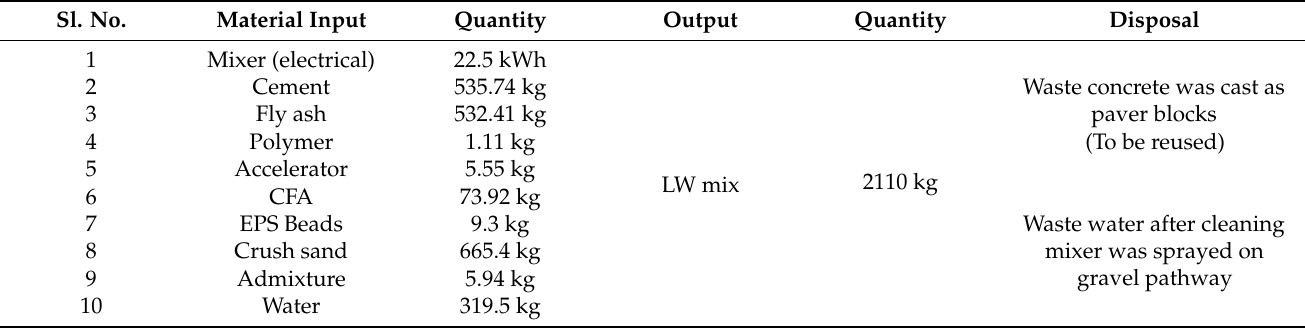
Table 6. Inventory details of Phase C—Mixing of CFA-based LW mix.